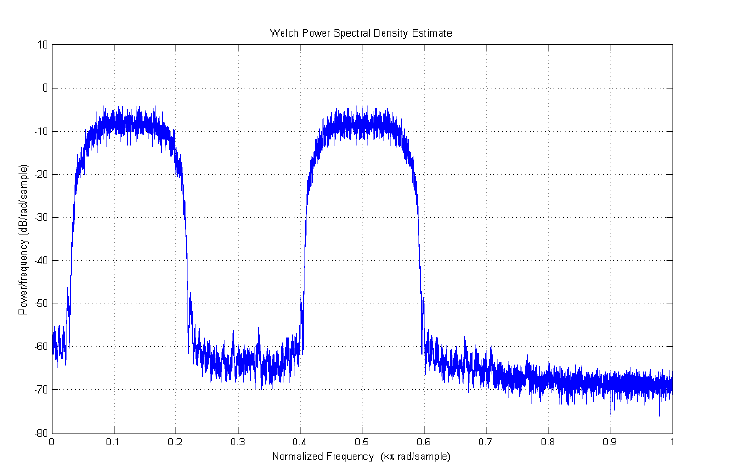
Figure 6. Test case 1 measured.